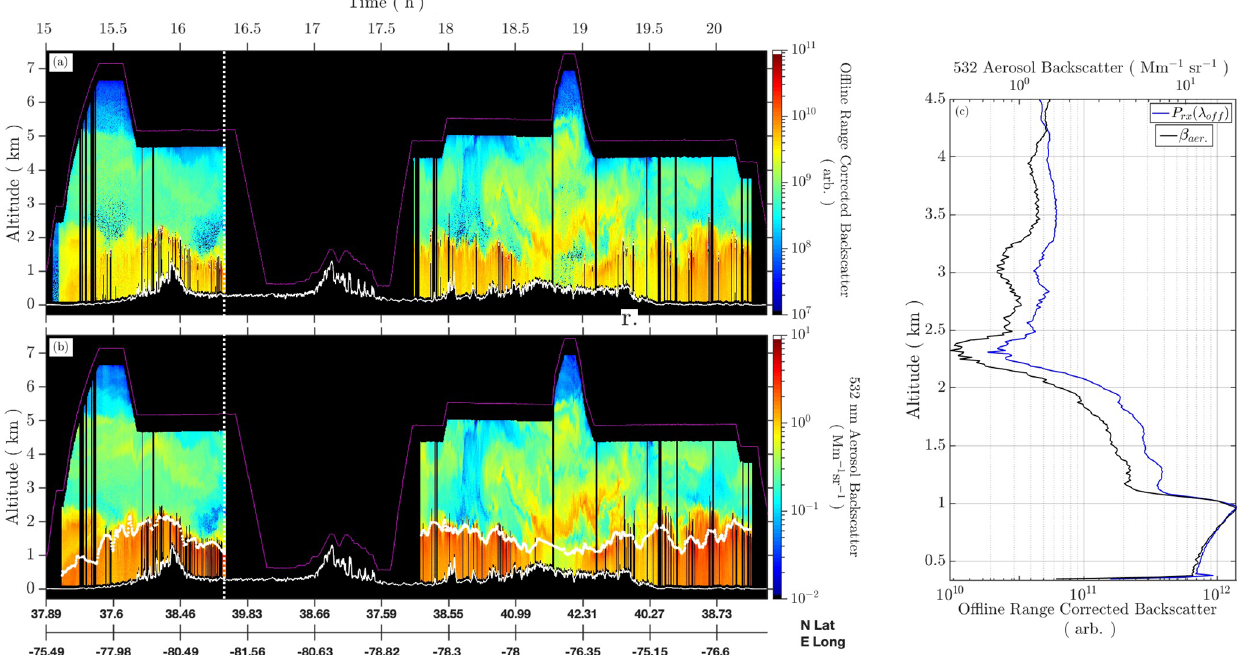
Figure 15. Examination of 1645nm offline backscatter from 20 July. (a) Range-corrected offline backscatter profiles (15m; 10s). (b) HSRL aerosol backscatter at 532nm (15m; 10s) with MLH in white. The flight track, magenta, and DEM height, white, are shown in each panel. Each curtain was cloud cleared with the HSRL cloud top height, black striations. (c) Profiles of offline backscatter and the HSRL aerosol backscatter from the vertical white lines shown in panels (a) – (b) (15m;